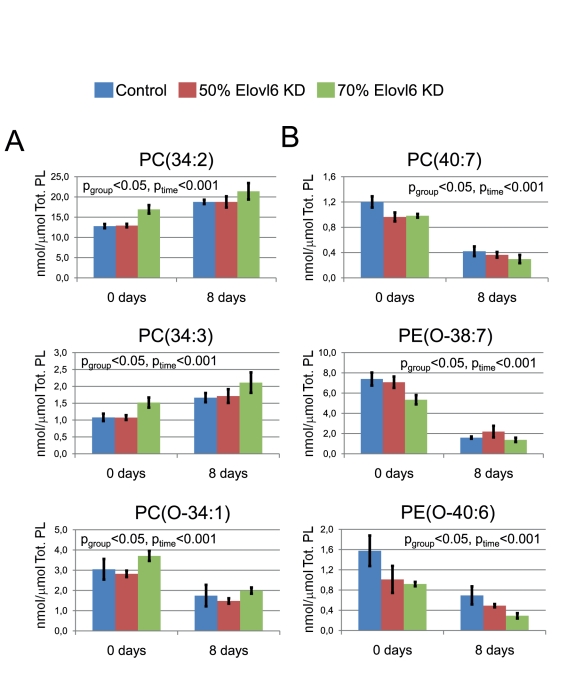
Regulation of lipidomic profiles by Elovl6 in differentiated
adipocytes.3T3-L1 preadipocytes were differentiated in wild-type (control) cell
line, and following 50% and 70% Elovl6 knockdown (KD)
(three biological replicates for each group). Lipidomic analysis was
performed in preadipocytes and in mature adipocytes. One-way ANOVA was
performed to test for the significance of time (mature adipocytes versus
preadipocytes) and group-specific lipid changes. Error bars are ±
SEM. Tot. PL, total phospholipids as measured by lipidomics. (A) The
upregulated phospholipids in Elovl6 knockdown cells are mainly shorter
chain and saturated. Selected lipids are shown. (B) The diminished
phospholipids are mainly PUFA containing, predominantly ether lipids.
Selected lipids are shown. All differentially regulated phospholipids in
Elovl6 knockdown cells are listed in Table
S5.